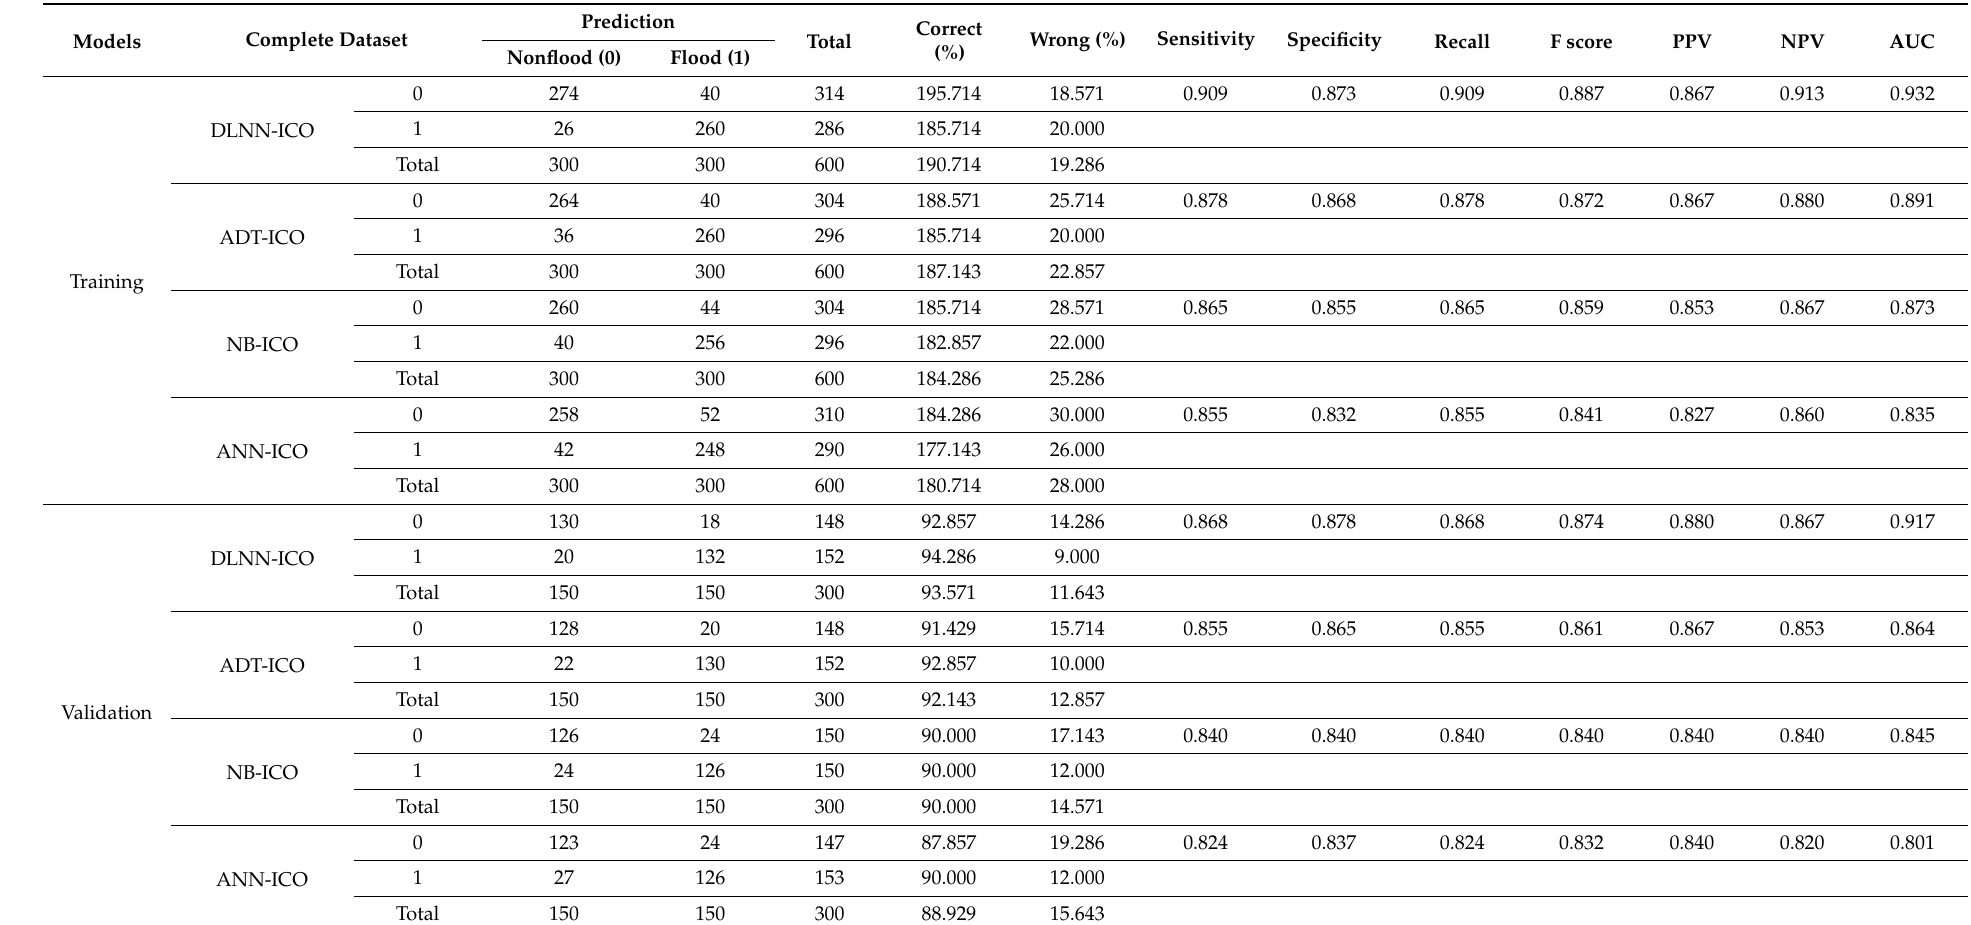
Table 2. Validation of the